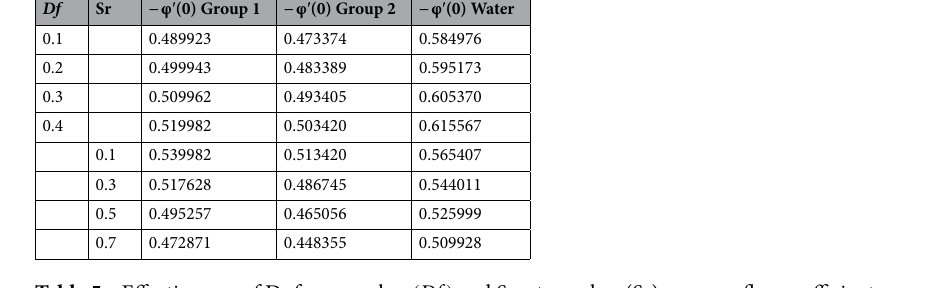
Table 5. Effectiveness of Dufour number ( Df ) and Soret number (Sr) on mass flux coefficient.